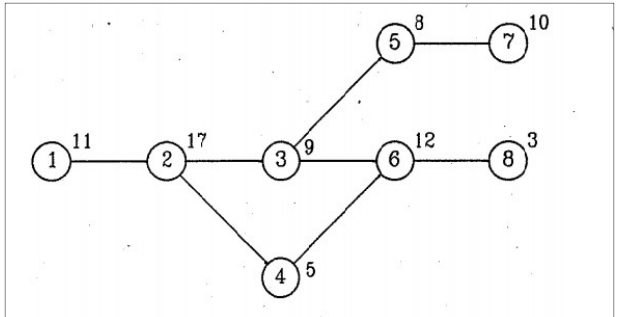
Figure 4. Precedence Diagram of the Bowman Problem [34].